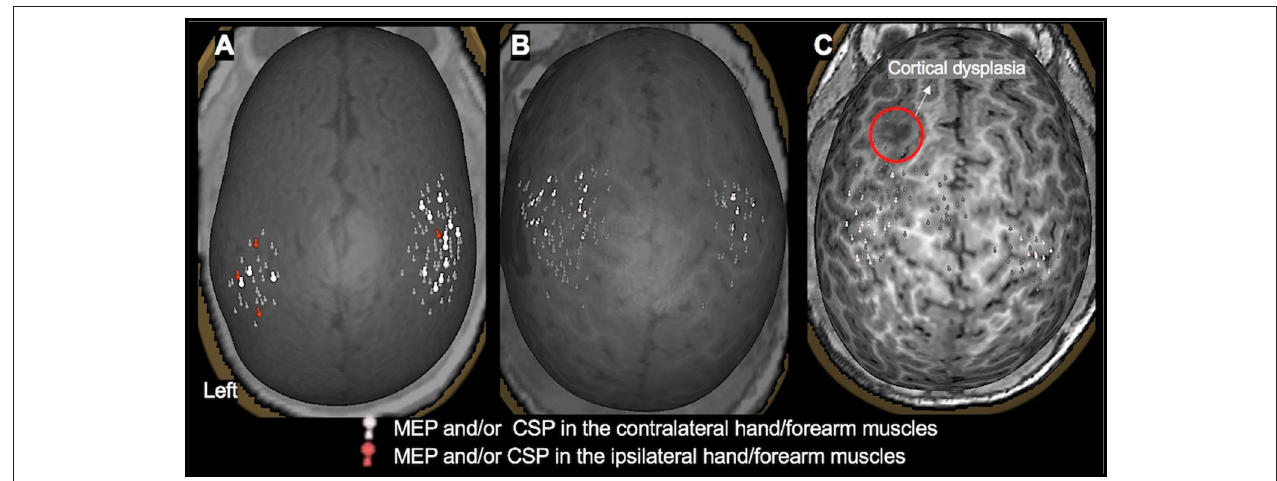
FIGURE 3 | TMS motor mapping demonstrating normal motor development in children under 3 years of age. (A) : A 3-month-old male with dysplasia along the inferior frontal sulcus involving the inferior aspect of the right precentral gyrus, inferior gyrus, frontal gyrus, and middle frontal gyrus and history of infantile spasms. The motor cortices were localized along the precentral gyrus with MEPs elicited in contralateral and ipsilateral hand muscles, representing a normal developmental variant. (B) : An 18-month-old female with history of left hemisphere perinatal stroke involving left temporal lobe and subsequent infantile spasms demonstrating a normal motor